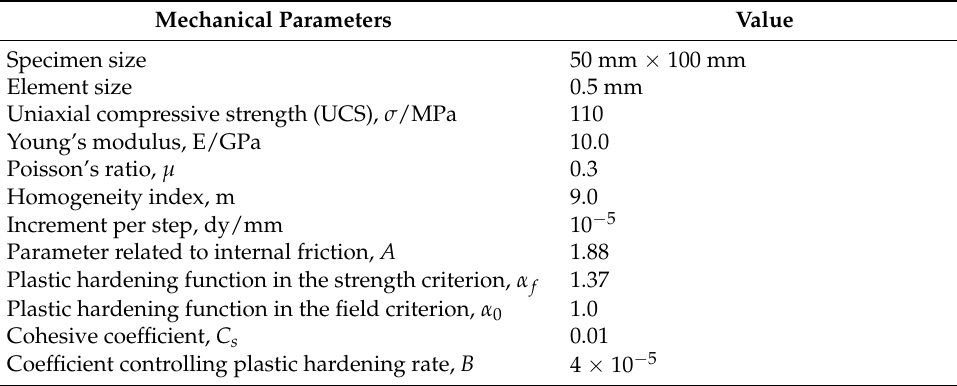
Figure 4. Fitted yield and fracture surfaces from experimental data. ( A ) Axial differential stress vs. axial strain curves under different confining pressures. ( B ) Effective deviatoric stress vs. mean effective stress for the yield surface and the failure surface. Table 1. Physical ‐ Mechanical Parameters in Numerical Models.